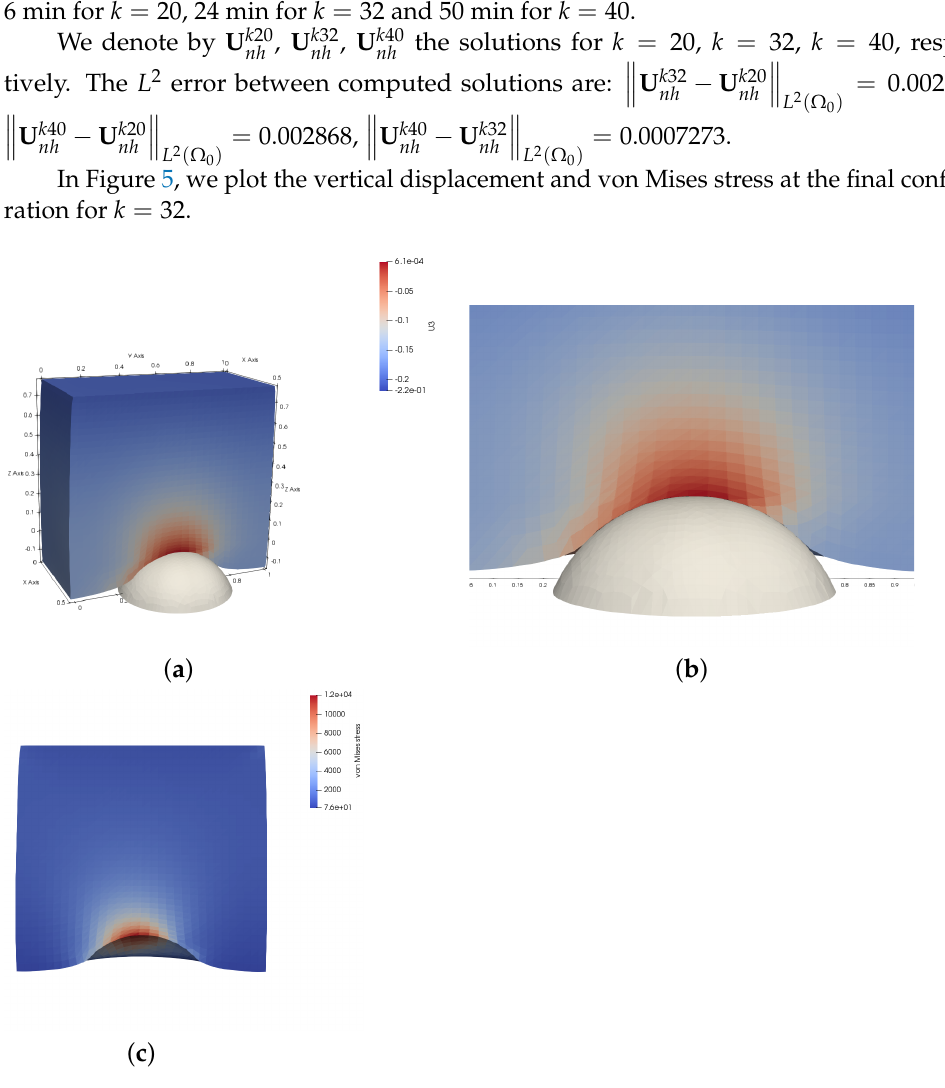
Figure 5. Cube, k = 32, cut of the final configuration: vertical displacement U 3 ( a ), zoom of the contact zone for U 3 ( b ), von Mises stress ( c ).